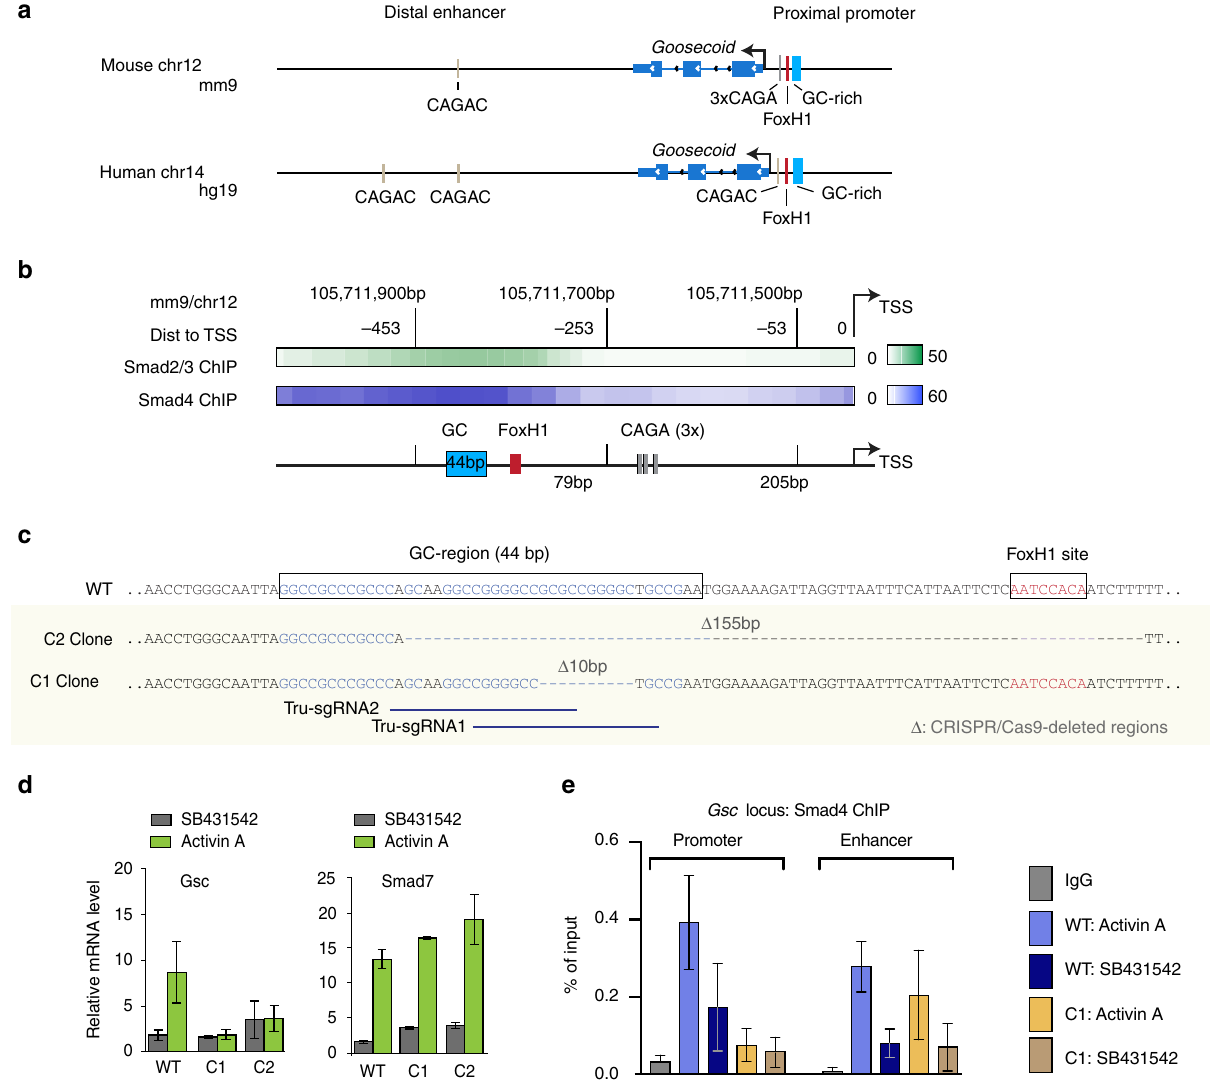
Fig. 1 Motif identi fi cation in Gsc promoter using ChIP-Seq and CRISPR/Cas9. a Schematic representation of the proximal promoter and distal enhancer sites of mouse and human Gsc showing the GC-rich region, CAGAC, and the FoxH1 binding sites. b Heatmap of ChIP-Seq tag densities for Smad2/3 (GSM1782914 62 ) and Smad4 (GSM2746361, this work) located at − 600 bp from the TSS of Gsc, showing how the signal is centered at the GC-rich region. Coordinates referred to the mm9 genome assembly. Data are displayed for chromosome 12 between 105,711,900 and 105,711,700 bases. c Scheme of the CRISPR/Cas9-mediated mutagenesis of the Gsc proximal promoter region. CRISPR-mediated deletions of a 10 bp region of the Gsc GC1 site (Clone C1) and of the GC1-FoxH1 region (155 bp, Clone C2) are indicated with dashed lines. The DNA sequence of targeted regions is represented as blue horizontal bars. Deletions were con fi rmed by deep sequencing and TA cloning (Supplementary Fig. 1e, f). d The effects of the deletions are shown as the relative mRNA levels of Gsc and Smad7 used as a control of the TGF-beta signaling pathway. qRT-PCR analysis of Gsc mRNA expression in wild type (WT) or Gsc mutant clones and of Smad7 expression in activin A- (green) or SB431542- (gray) treated d3 cells. Gene expression level is normalized to WT samples, n = 3. Error bars represent s.e.m., P < 0.05, Mann – Whitney test using Prism 6 software (GraphPad Software). e Smad4 ChIP-qPCR data ( n = 2) in ES cells showing that the 10 bp deletion in the GC-rich region abolished Smad4 interaction with this region without affecting Smad4 interaction with the Gsc +6 kb distal enhancer element. Error bar represents